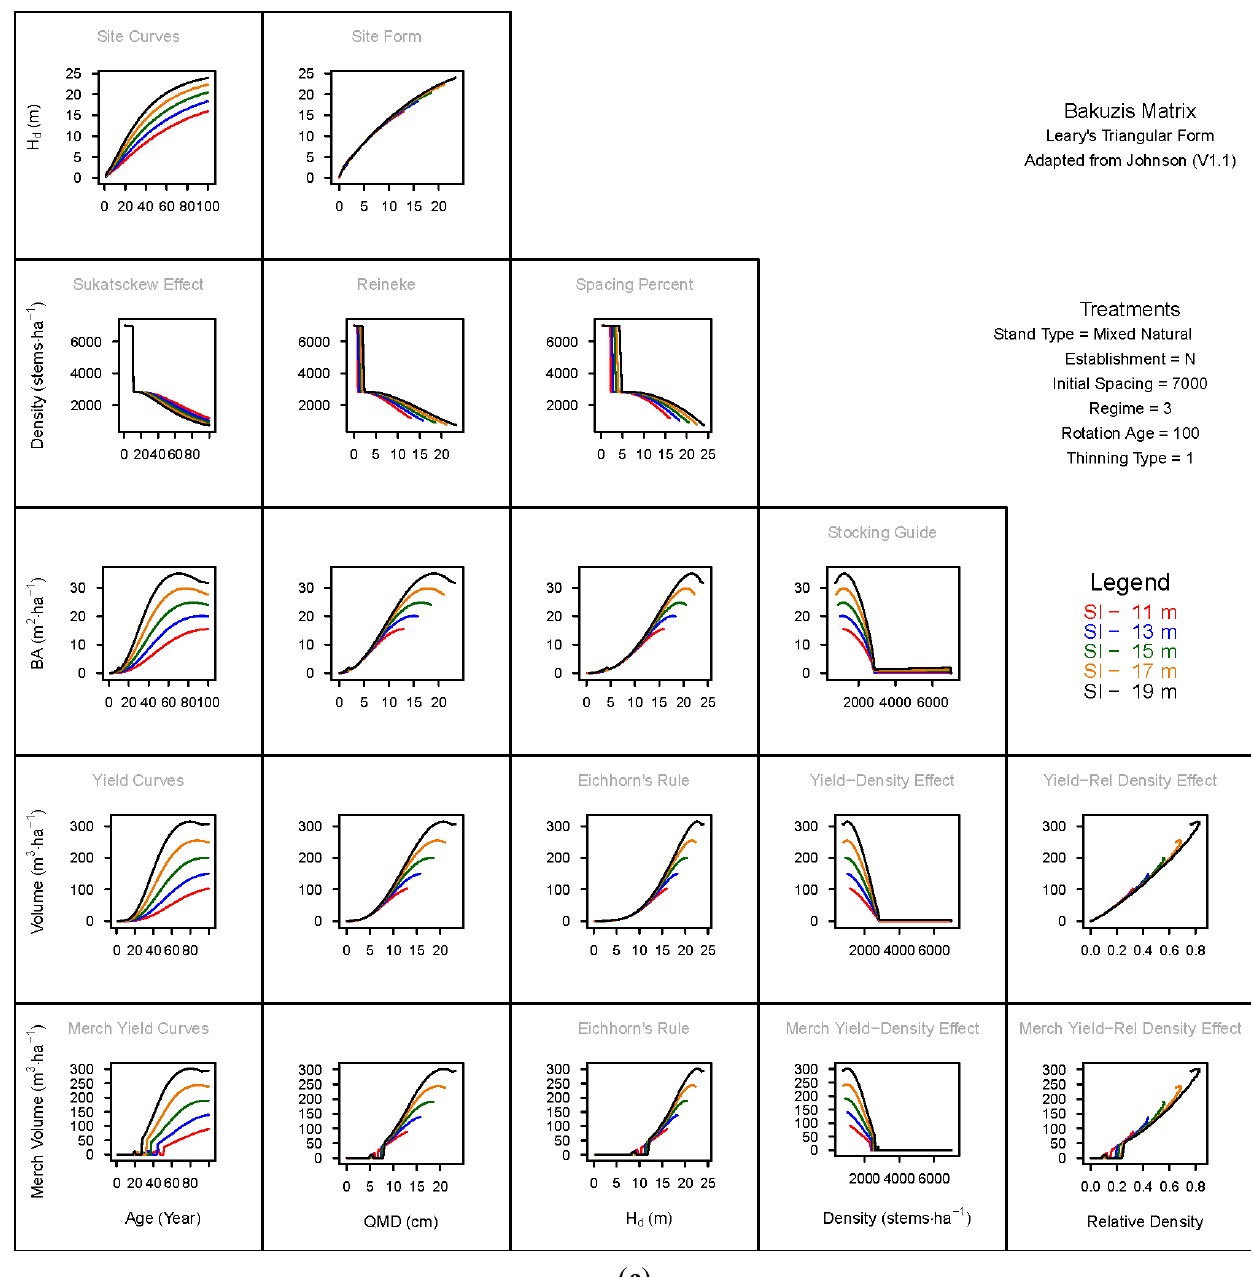
Figure A4. Bakuzis matrices for unthinned and precommercially thinned (PCT) black spruce and jack pine mixed stands which were established naturally (N) at an initial densities of 7000 stems/ha and grown on 5 site qualities (SI) over 100 year rotations: ( a ) Regime 1 represented unthinned control stands; ( b ) Regime 2 was initially identical to Regime 1 but the stands were subjected to a single PCT treatment at a stand age of 10 years in which stand densities were reduced to 2862 stems/ha and the maximum thinning response model setting was employed; and ( c ) Regime 3 was identical to Regime 2 but the stands utilized the minimum thinning response model to account for accelerated growth arising from the PCT